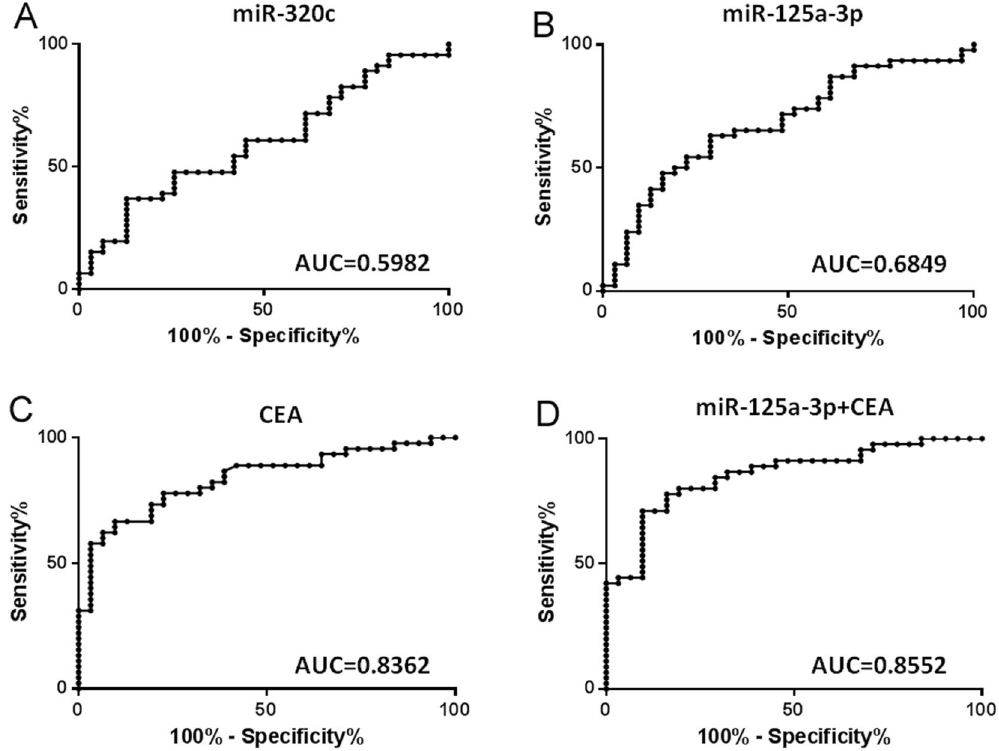
Figure 3. Diagnostic power of each tumor marker determined by ROC curve. Serum level of CEA and the expression level of miR-320c and miR-125a-5p were respectively stratified into high and low group with their geometric mean as cut-off. The performance of miR-30c ( A ), miR-125a-3p ( B ), CEA ( C ), and miR-125a-3p plus CEA ( D ) yielded area under the ROC curve (AUC) values of 0.5982 ( P < 0.1459), 0.6849 ( P = 0.0156), 0.8362 ( P < 0.0001), and 0.8552 ( P < 0.0001).